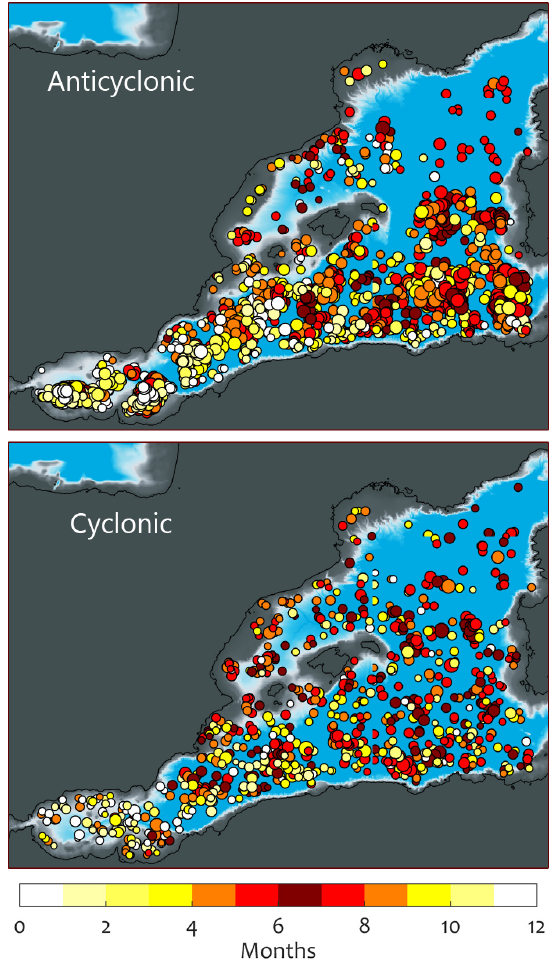
Figure 9. Spatial distribution of mesoscale eddy manifestations found in the fields of SST in 2011-2013 in the westernmost part of the Western Mediterranean